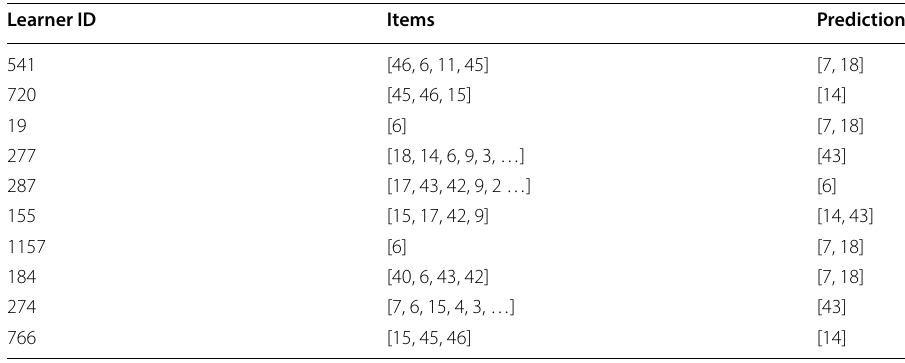
Table 4 Courses recommender system